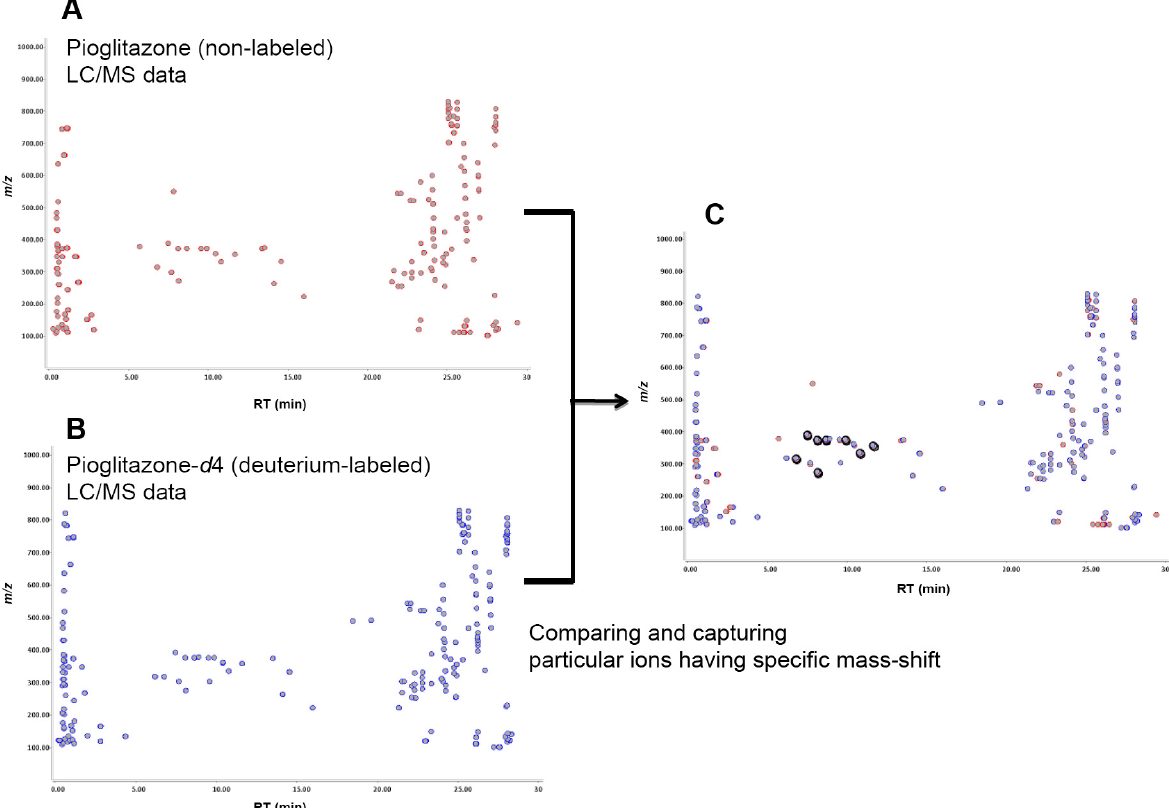
Figure 2. The concept of drug metabolite detection using stable isotopic mass-shift filtering. LC-MS data sets for un-labeled ( A ) and labeled ( B ) compounds were aligned, and the ions having a specific mass-shift equal to the mass of the labeled isotope were computationally filtered and visualized using the Signpost MS software ( C ). Metabolite ions, derived from the un-labeled compound and the labeled compound, are shown in red and blue,